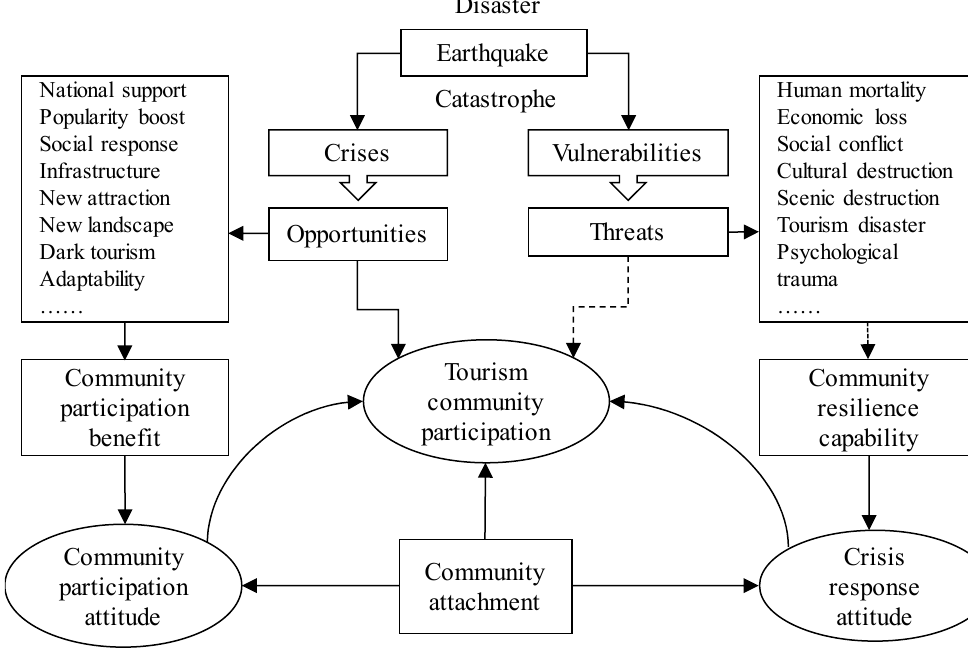
Figure 4. Tourist community participation ABC framework based on crisis response.